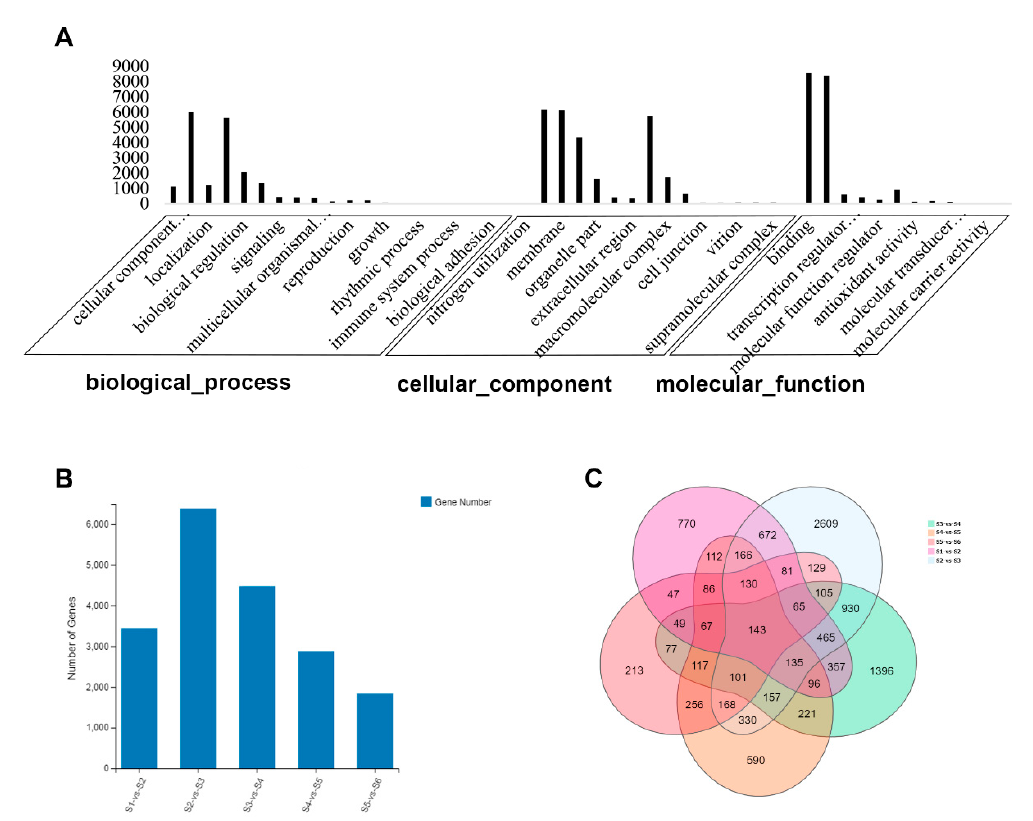
Figure 6. Differentially expressed genes (DEGs) during rhizome development. ( A ) GO annotation of total genes in the transcriptomes. ( B ) Histogram of DEGs at six stages. ( C ) Venn diagrams of DEGs among samples.